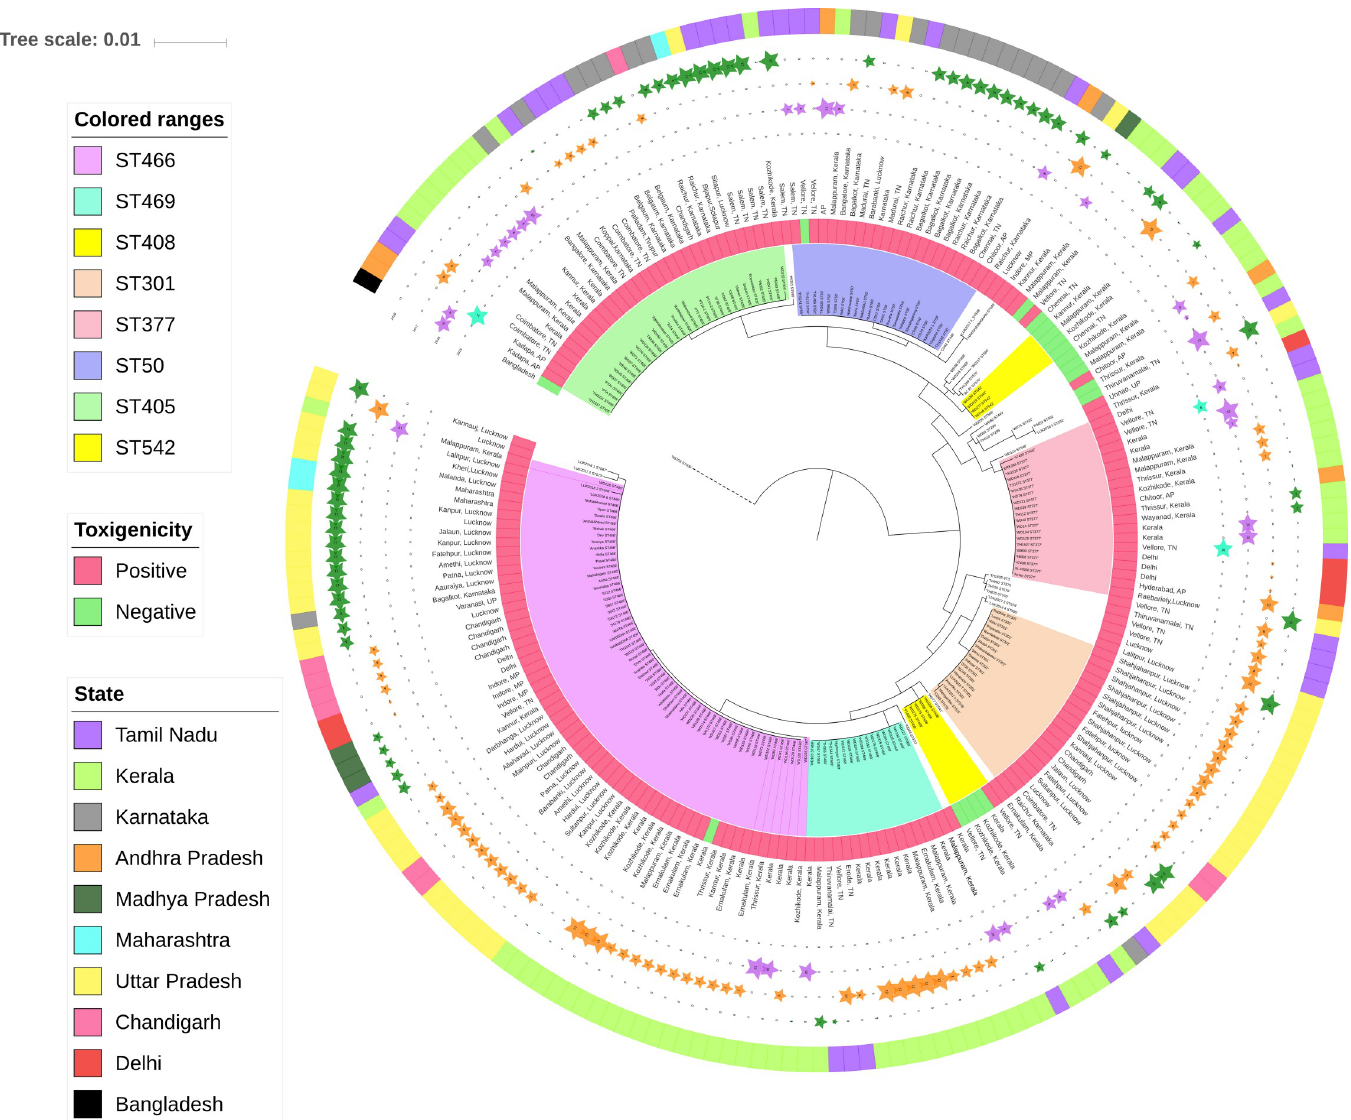
Fig 2. Maximum likelihood phylogeny of MLST alleles from 216 C . diphtheriae isolates. The clades are highlighted based on the common ST types identified in the study. STs associated with non-toxigenic strains are highlighted in yellow. The inner ring represents the toxigenicity results of the isolates followed by date of collection. The outer ring represents the region of